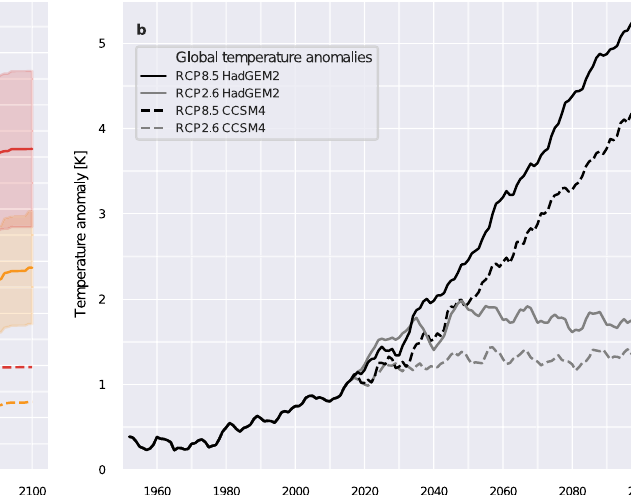
shadedareasshowtheuncertaintyrangeduetothespatialextrapolationsbasedon the twopoint process models (PPM1 and PPM2). b The related global temperature increase is shown as an anomaly compared to the pre-industrial period (1850 –